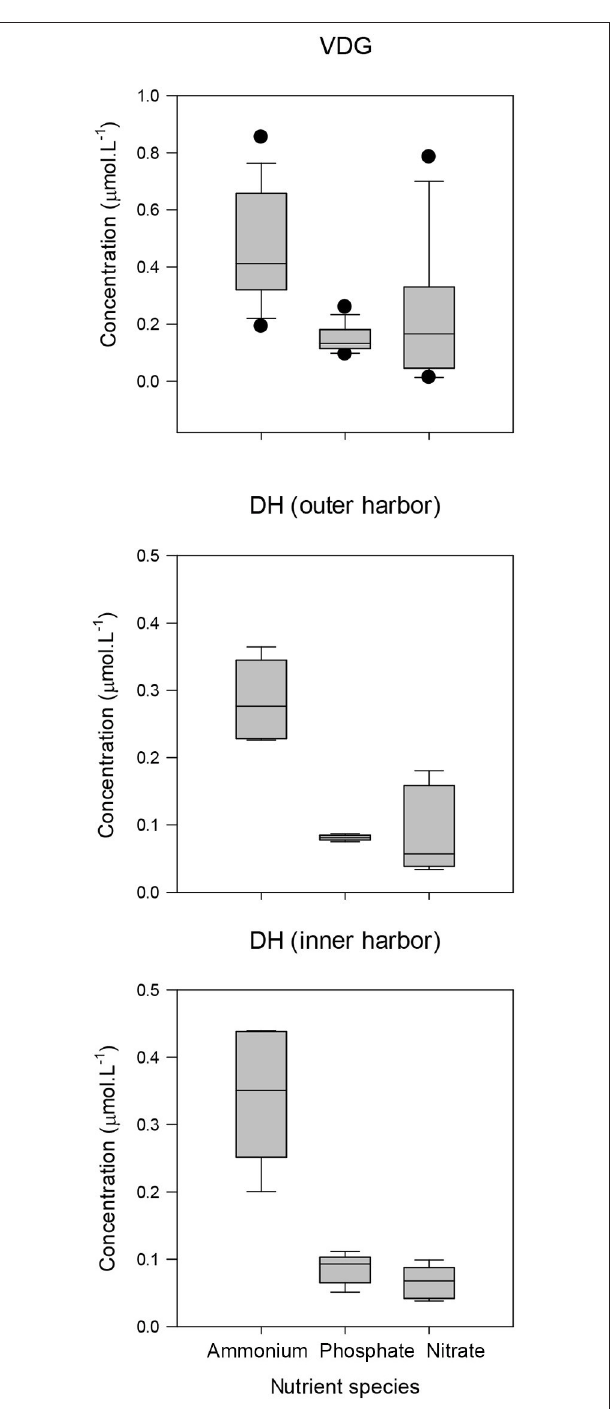
FIGURE 14 | Boxplots of the nutrient budget for VDG and DH (inner and outer harbor). Note change of scale.